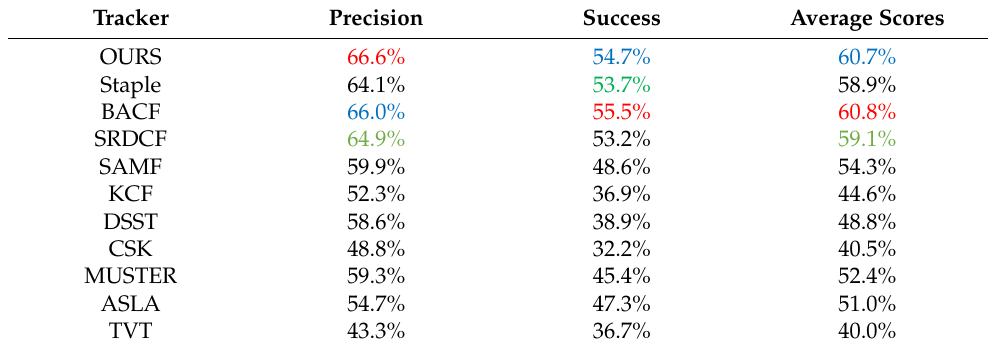
Table 4. Average performance of algorithms on the UAV123 dataset.